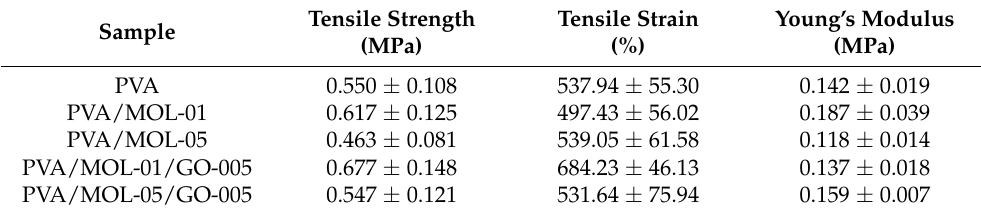
Table 1. Data of the PVA/MOL/GO hydrogel tensile strength and